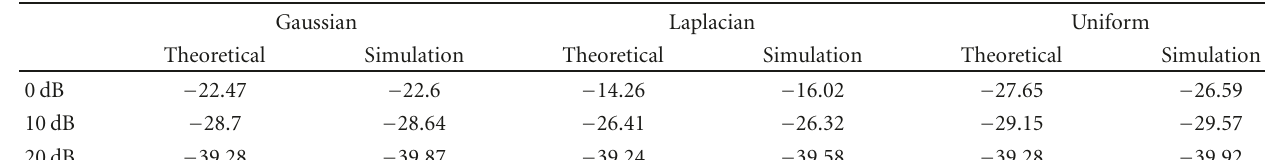
Table 2: Theoretical and simulation EMSE for p = 4, α = 0 . 8.